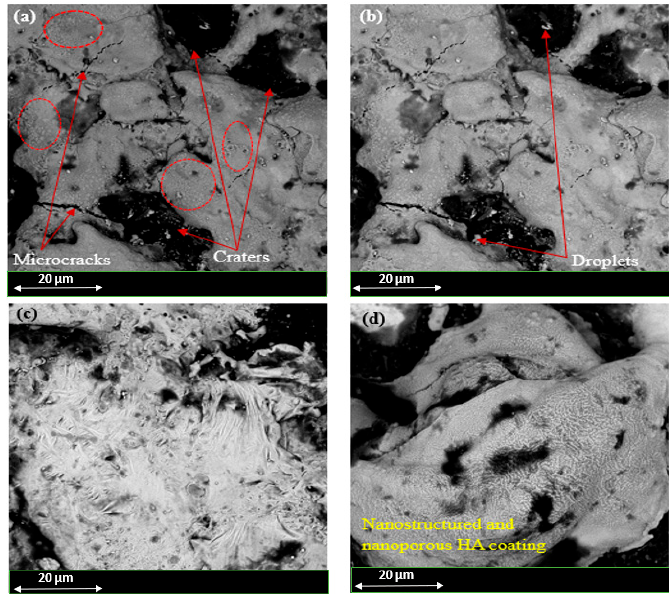
Figure 7. SEM micrographs of the Zr 67 Cu 11 Ni 10 Ti 9 Be 3 BMG processed at constant P c = 8 A and D d = 8 µs while varying the HA powder concentration: ( a ) 0 g/L, ( b ) 5 g/L, ( c ) 15 g/L, and ( d ) 20 g/L.